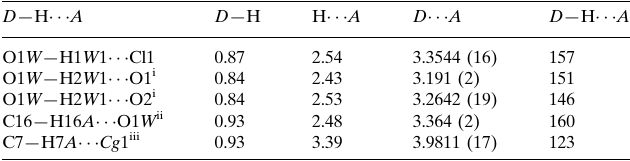
Data collection Bruker SMARTAPEX2 CCD area- detector diffractometer Absorption correction: multi-scan ( SADABS ; Bruker, 2005) T min = 0.714, T max = 0.915 Refinement R [ F 2 > 2 (cid:1) ( F 2 )] = 0.037 wR ( F 2 ) = 0.100